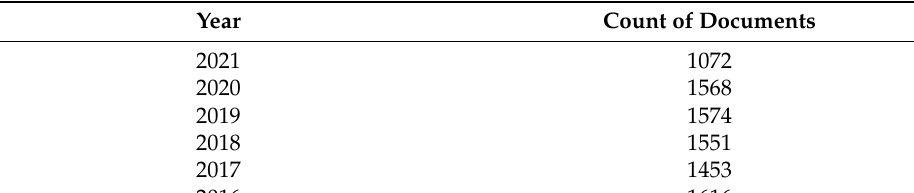
Table 1. Published documents in the Scopus per year (2016–2021).